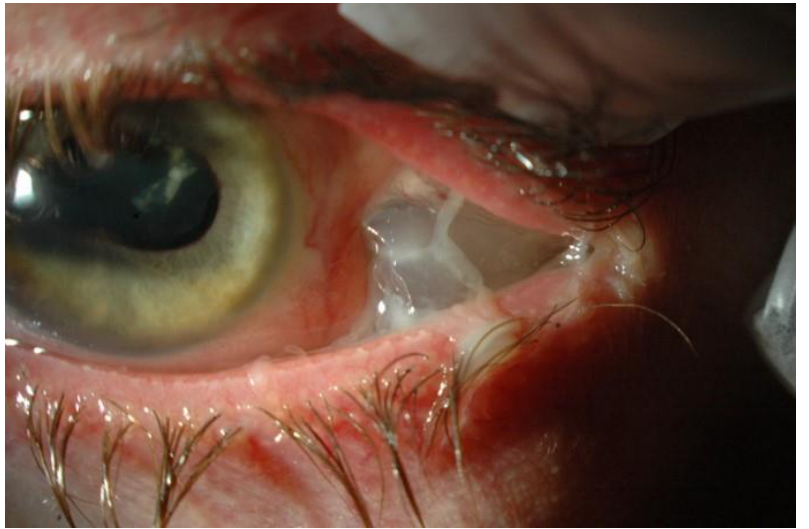
Figure 3. A left aphakic eye with an extrusion of a MIRAgel (hydrogel) buckle through the temporal conjunctiva.